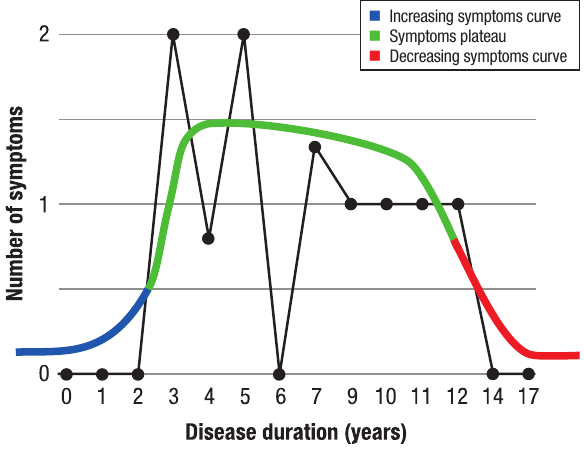
Figure 1. The Inverted-U theory. Black graph shows the distribution of the number of symptoms with disease duration. Initially, the number of symptoms increased with disease progression (Increasing Symptoms Curve), followed by a constant presentation of symptoms (Symptoms Plateau) and a decrease in symptoms at the advanced phase of dementia (Decreasing Symptoms